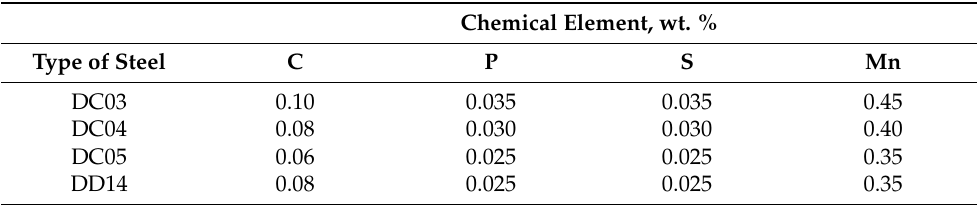
Table 3. The standardized maximum content of alloying elements in the investigated steel grades, wt. % [31].